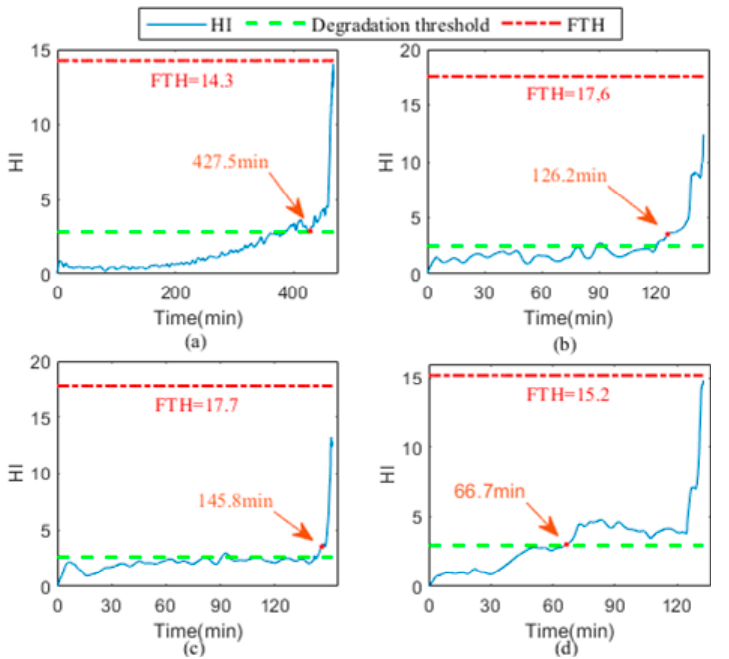
Figure 11. HIs for TTF prognostics of ( a ) bearing 1_1, ( b ) bearing 1_2, ( c ) bearing 2_1, and ( d ) bearing 2_2.